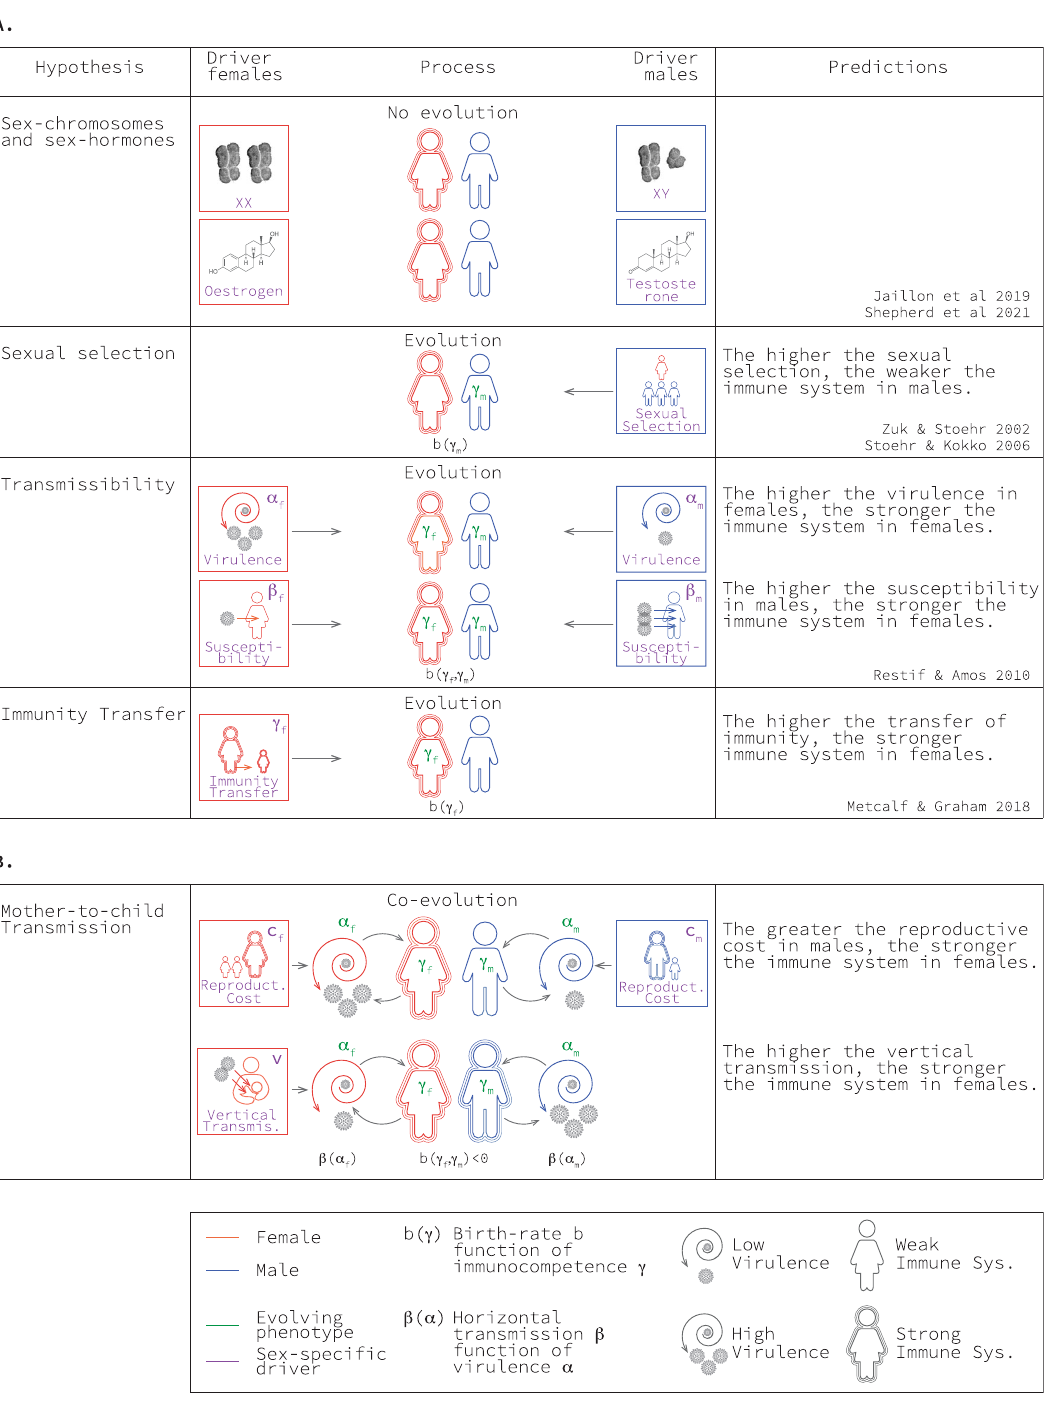
Fig. 1 | Hypotheses explaining stronger immunocompetence in women. Sum- mary of the phenotypes evolving (in green), the drivers of their evolution